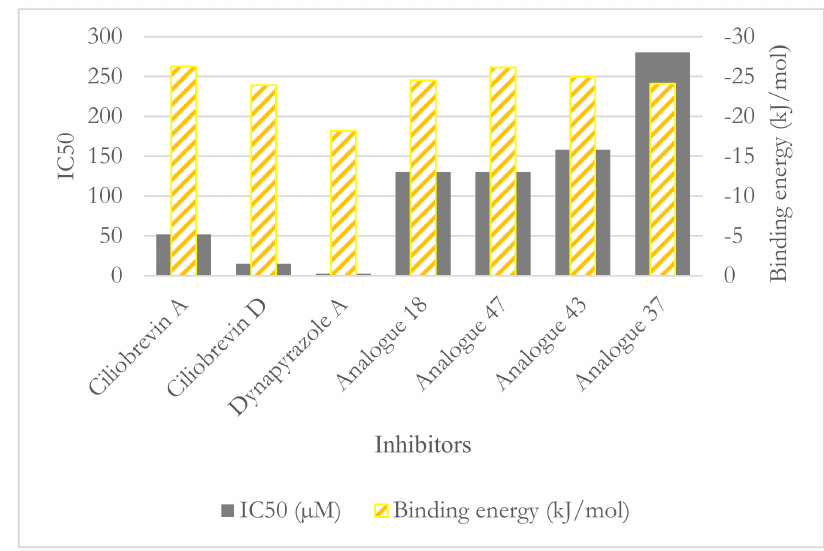
Figure 12. The ligands binding energy versus their IC 50